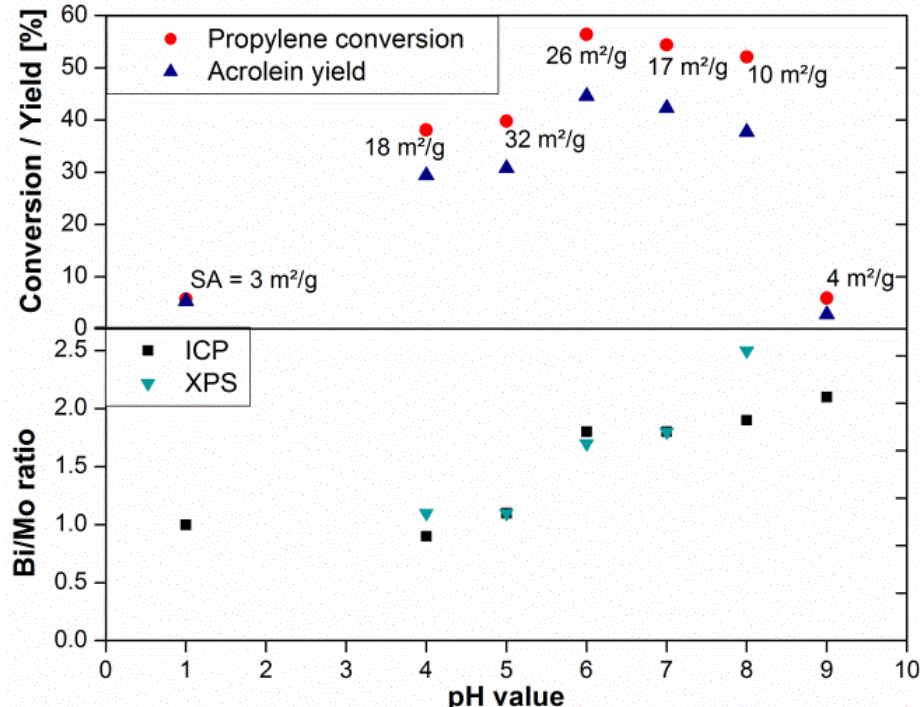
Figure 4. Correlation of the pH value in the initial solution, the Bi/Mo ratio determined in the bulk (ICP) and on the surface (XPS), and the catalytic performance at 360 °C using a flow of 50 NmL/min with a composition of C 3 H 6 /O 2 /N 2 = 5/25/70 and 500 mg of